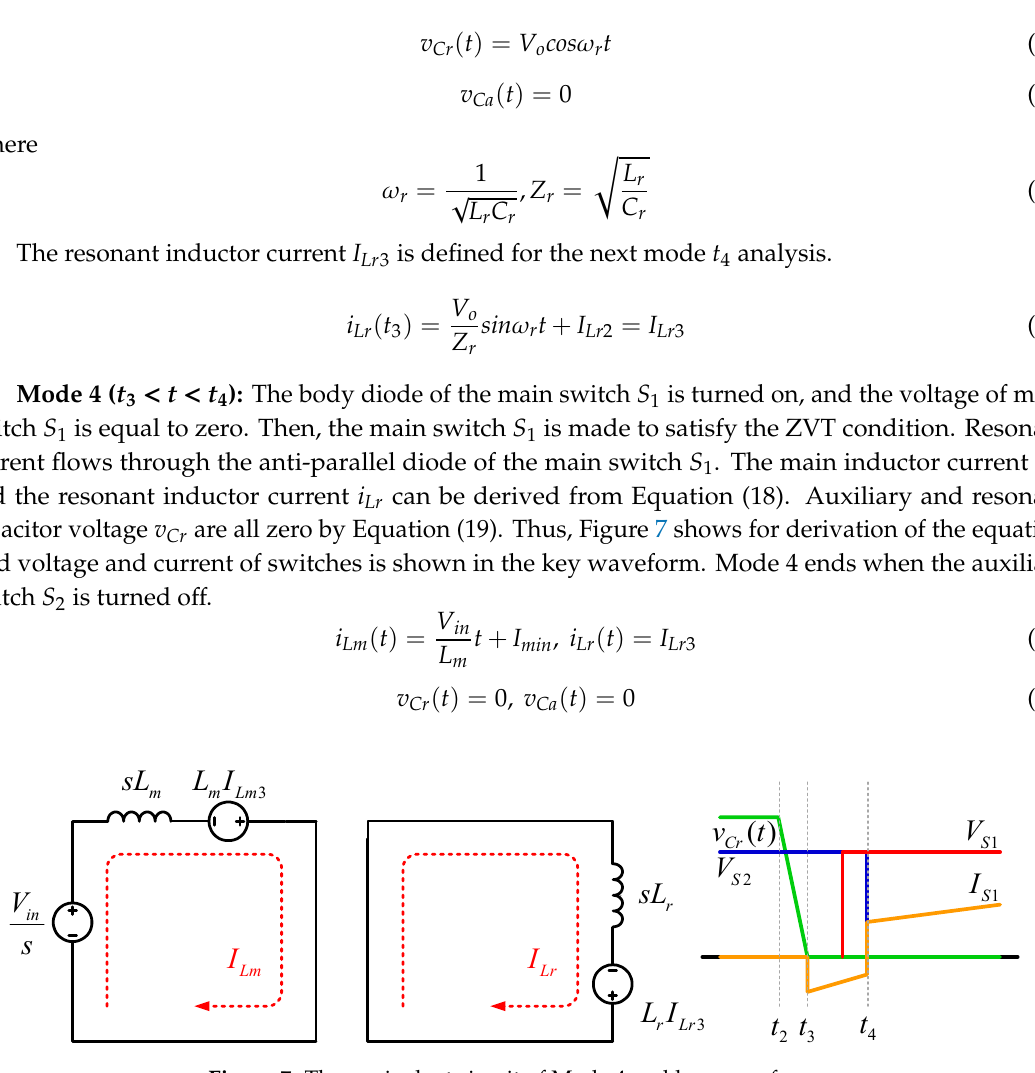
Figure 7. The equivalent circuit of Mode 4 and key waveform.